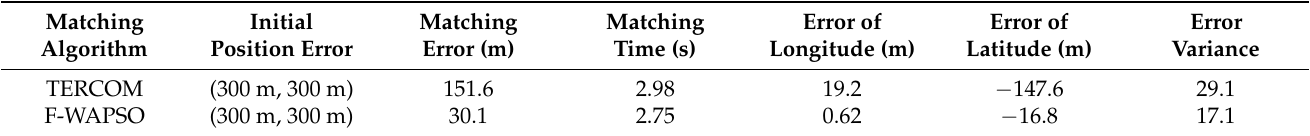
Table 3. Matching and error statistics of the two algorithms for trajectory A.